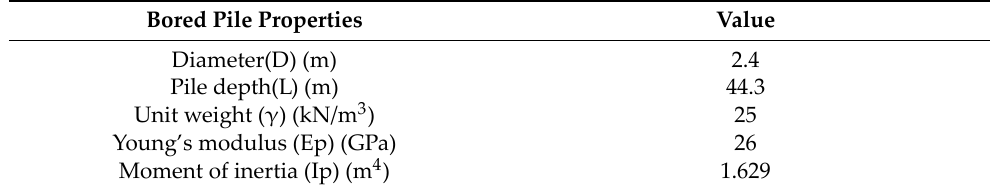
Table 1. Pile properties for bored pile LTP-4 (Reprinted from [20] with permission from Elsevier). Bored Pile Properties